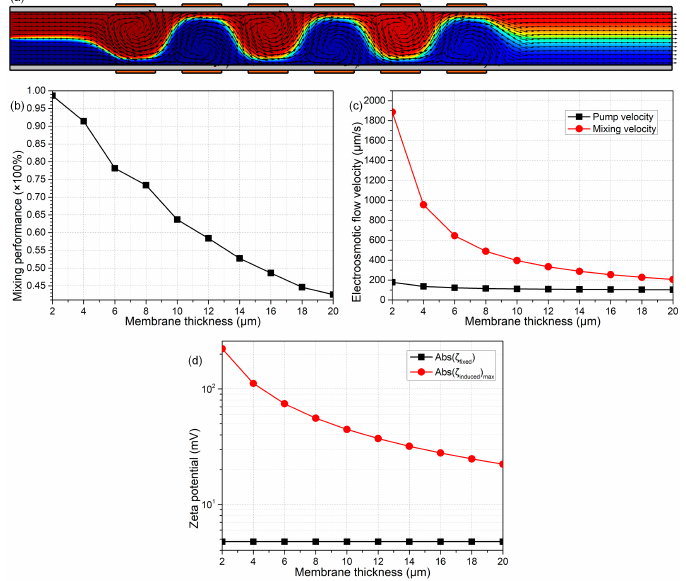
Figure 10. A simulation analysis of the influence of the thickness of dielectric membrane W ins on the device performance of sextuple-alternated B-DCFFET, under given values of Vs = 70 V, V G1 = − V G2 = 700 V, L G = 150 μm, L GG = 100 μm , σ f = 0.005 S/m and = –0.0002 C/m 2 . ( a ) An arrow and surface plot of DCEO streamlines and analyte molar concentration distribution (unit: mol/m 3 ) with W ins = 20 μm. ( b ) W ins -dependent device mixing efficiency. ( c ) Electroosmotic pumping and mixing flow velocity at different membrane thicknesses. ( d ) A quantitative comparison between the magnitude of native zeta potential | ζ fixed | and maximum induced zeta potential ζ maximum at induced the membrane/electrolyte interface, as a function of the membrane thickness W ins of the dielectric coating